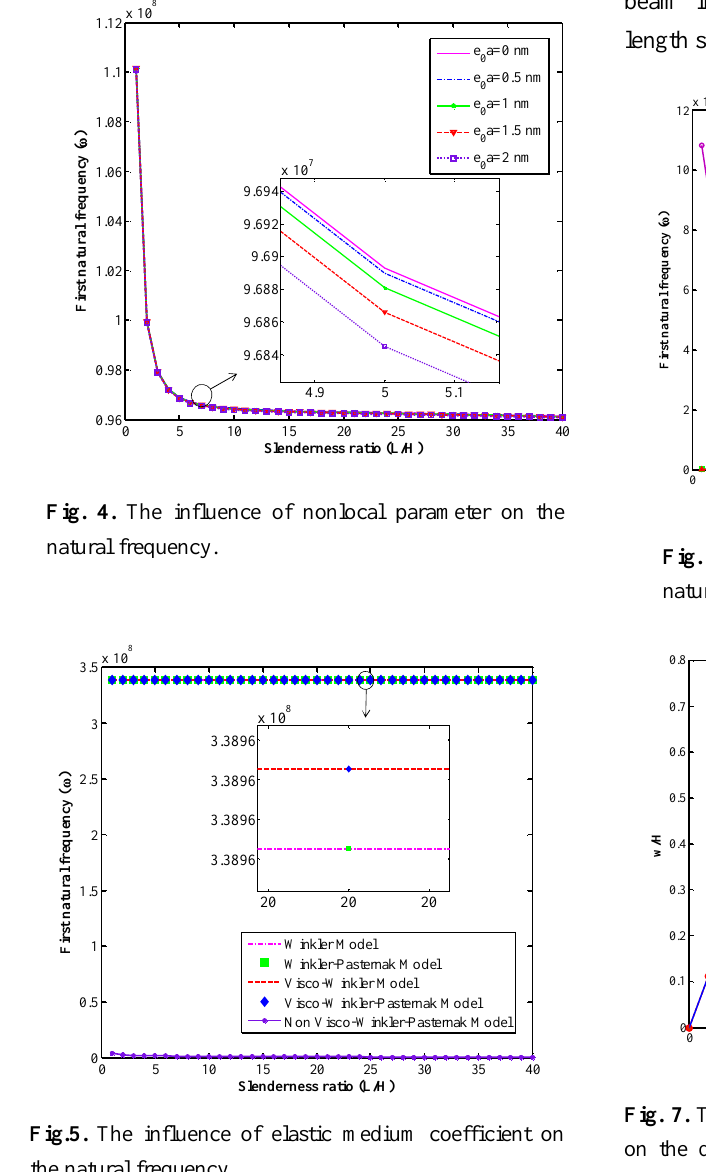
Fig.5. The influence of elastic medium coefficient on the natural frequency.